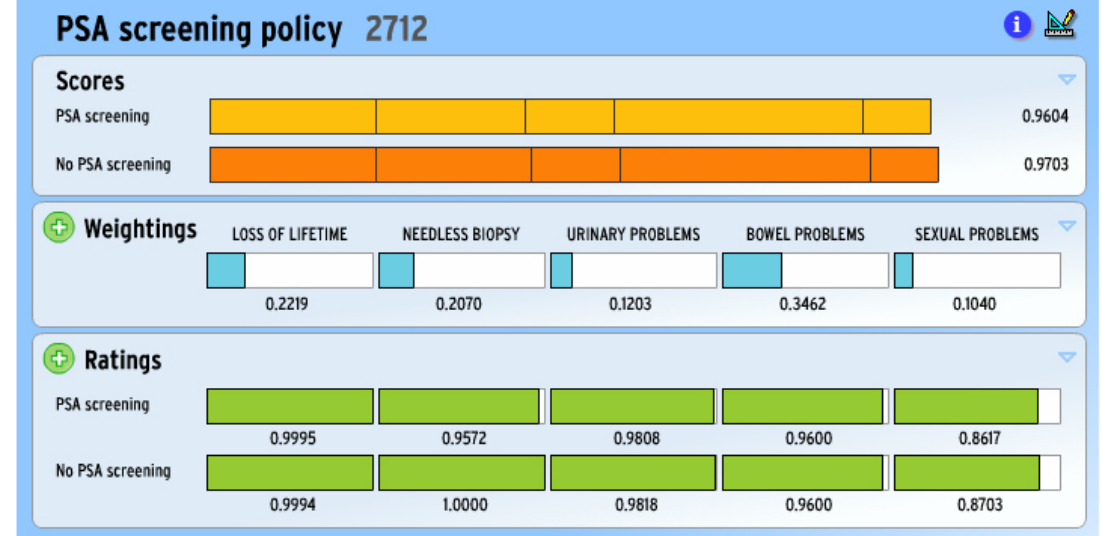
Figure 1. Example of PSA decision aid